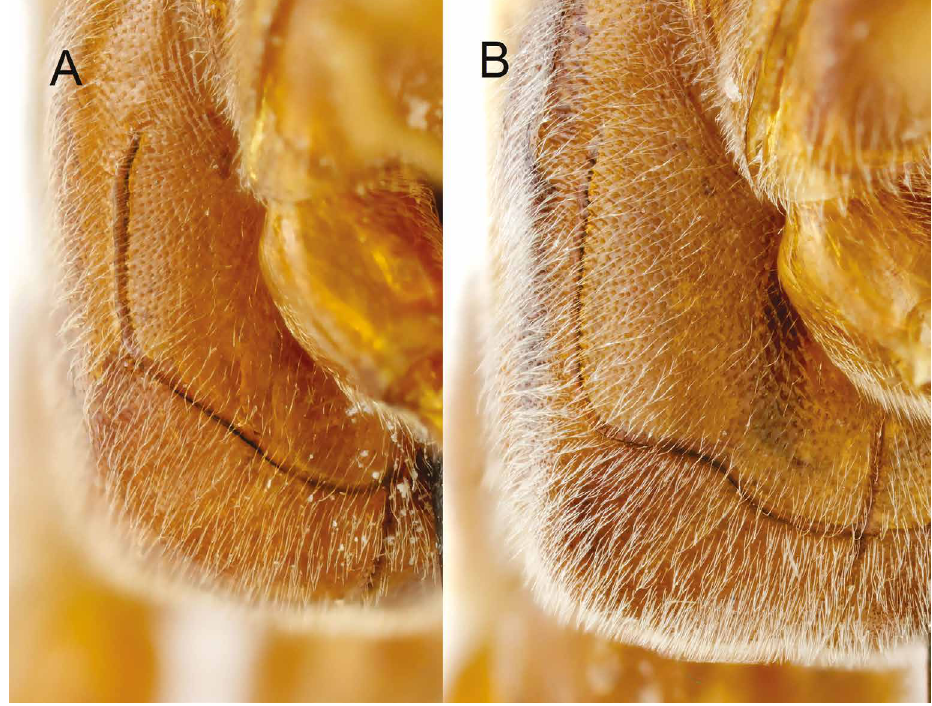
Fig. 12. Epicnemial carina, anterior view. A . Enicospilus ryrholmi sp. nov., paratype, ♀ (NHRS- HEVA000008173). B . E. adustus (Haller, 1885),